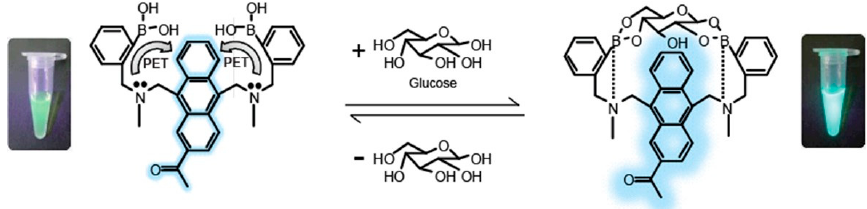
Figure 3. Glucose sensing mechanism of diboronic-acid-based fluorescence. Modified figures from those in Ref. [46].